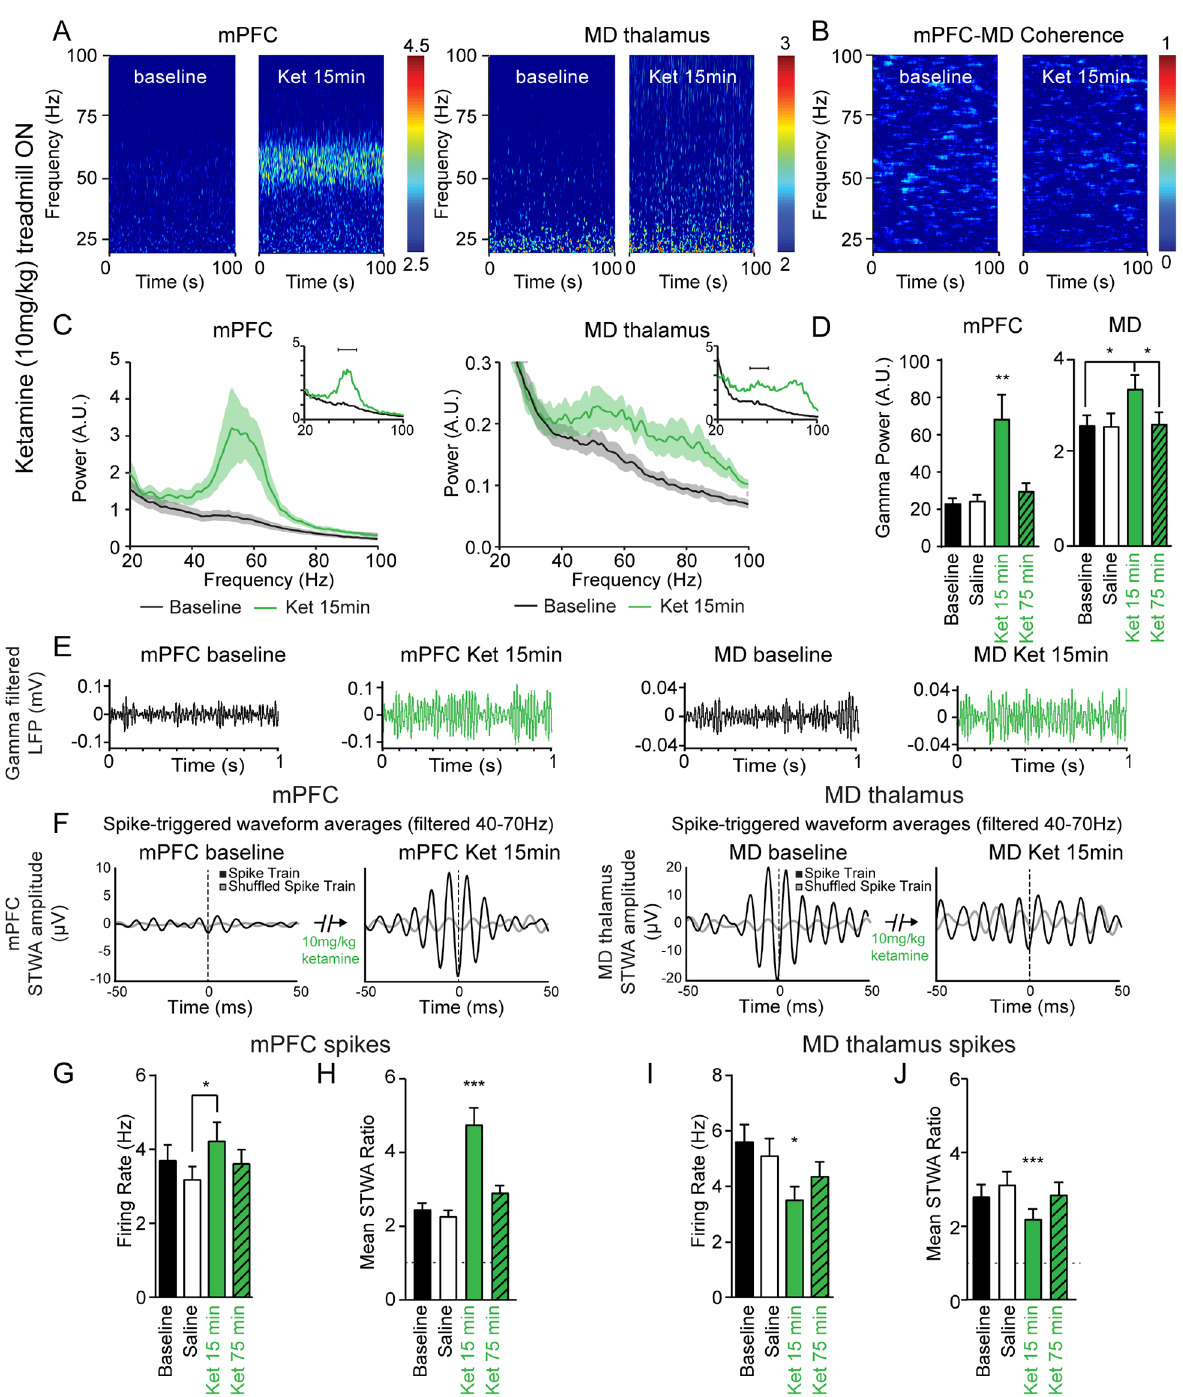
Fig 2. Ketamine-induced increasesin gamma LFP power and spiking activity during treadmill walking. A, Representative wavelet-based scalogramsshow the time-frequency plots of LFP spectral power before ketamine( baseline ) and 13–17 minutes after 10 mg/kg ketamines.c. ( Ket 15 min ). B, Representative FFT-based spectrogram shows time-frequency coherence between the mPFC and MD thalamusbefore ketamineand after ketamine. C, AveragedLFP power spectra for epochs before ketamine(black), and after ketamine(green). Insets show representative traces for each structure. D, Bar graph shows mean total gamma LFP power (peak ± 7 Hz) from the mPFC (n = 10 rats) and the MD thalamus(n = 6 rats) duringtreadmill walkingat baseline(black), 15 minutes after saline injection (white), and 15 minutes (green)or 75 minutes (green with diagonalstripes) after 10 mg/kg ketamineinjection. E, Representative examplesof gamma band-pass filtered LFP (40–70Hz) in the mPFC and MD thalamus. F, Representative STWAs of a mPFC pyramidal